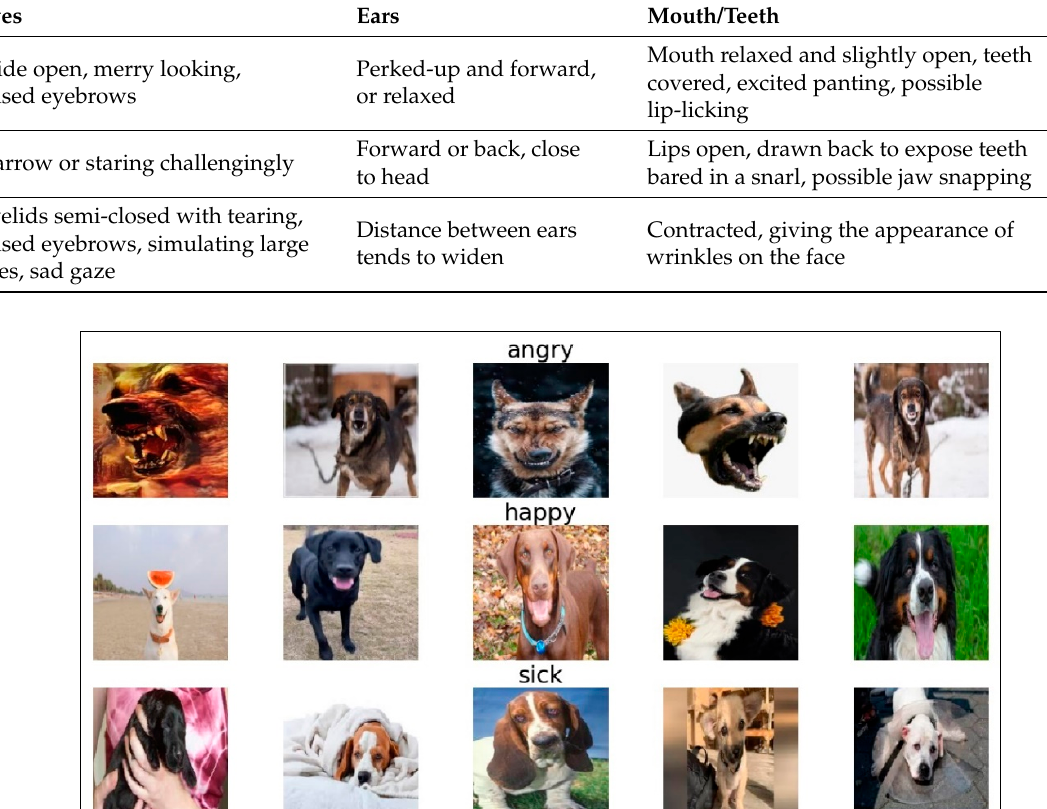
Figure 2. The overall framework of the proposed affective recommender.